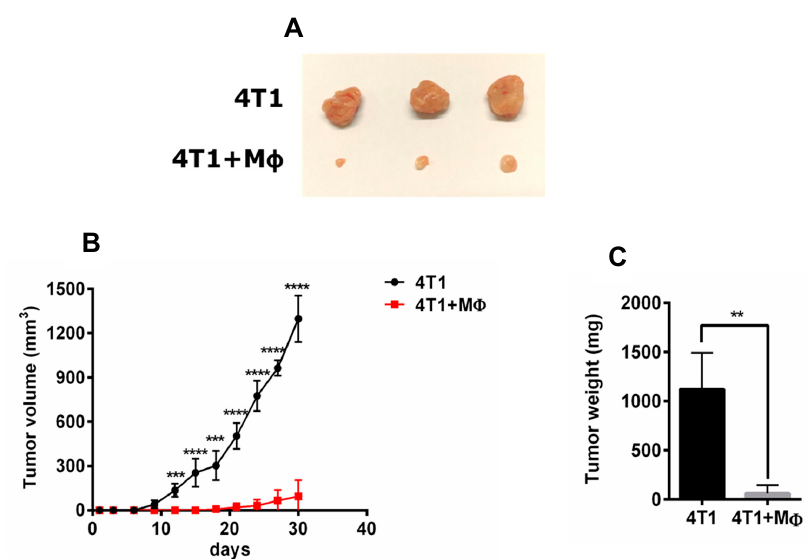
Figure 1. Tumoricidal effect of RAP-stimulated BMDMs in a 4T1-induced animal model. The BALB/c mice (3 mice/group) were injected with 4T1 cells and 4T1 cells plus BMDMs stimulated with RAP in